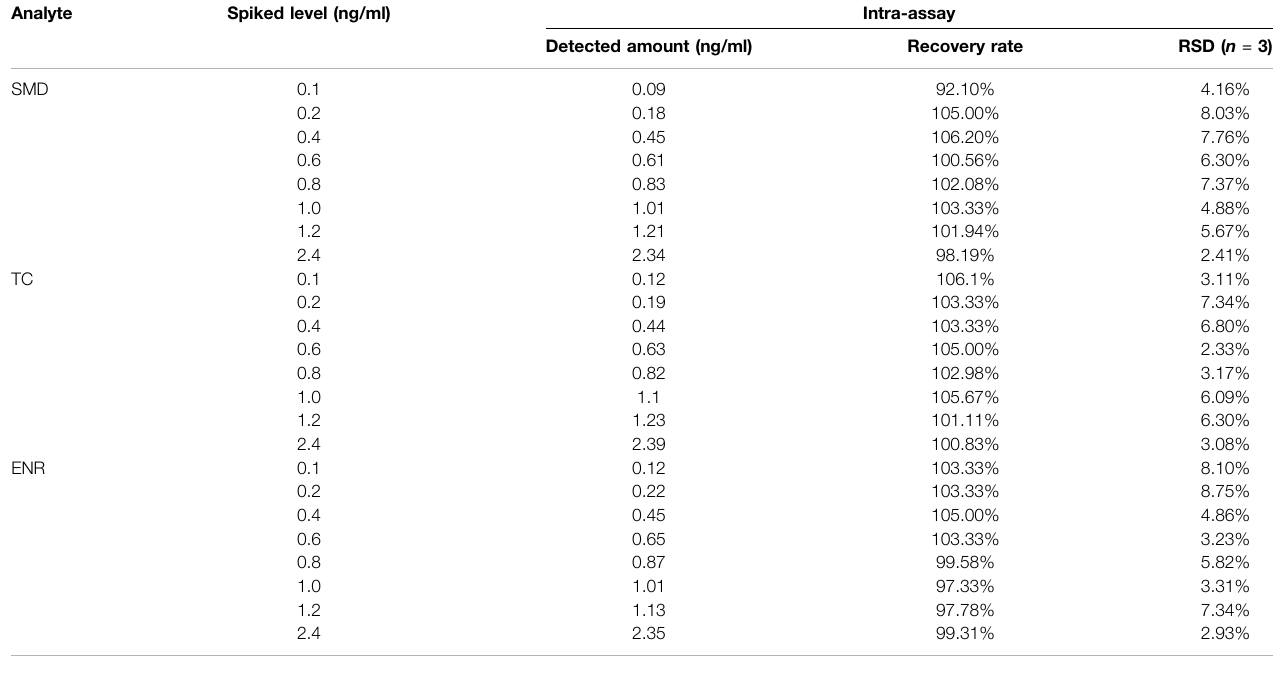
TABLE 4 | Recovery rate determination of SAs, TCs and FQs in milk sample from three-multiple-EuNPs-FIA analysis. Analyte Spiked level (ng/ml)